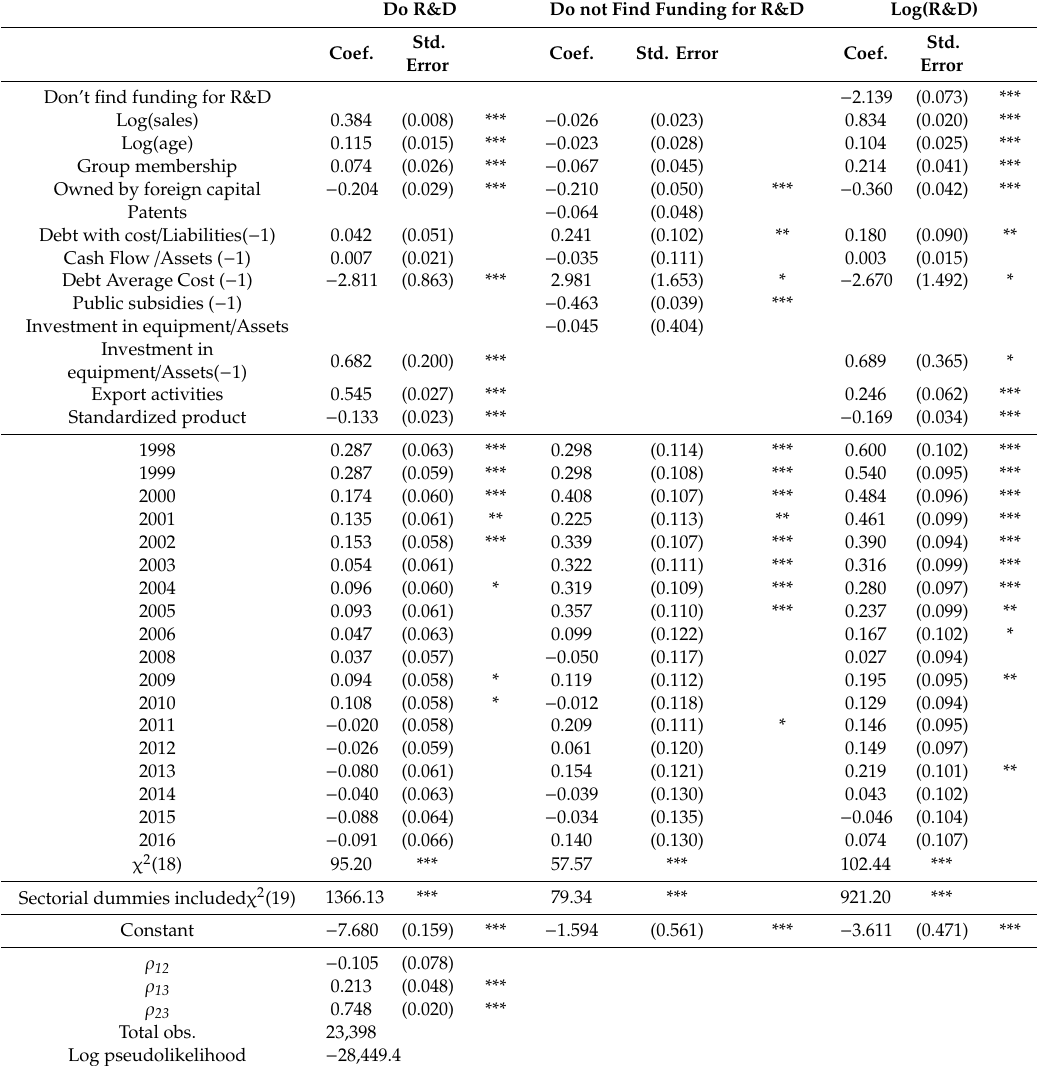
Table 3. Simultaneous mixed-process regression: model with temporal